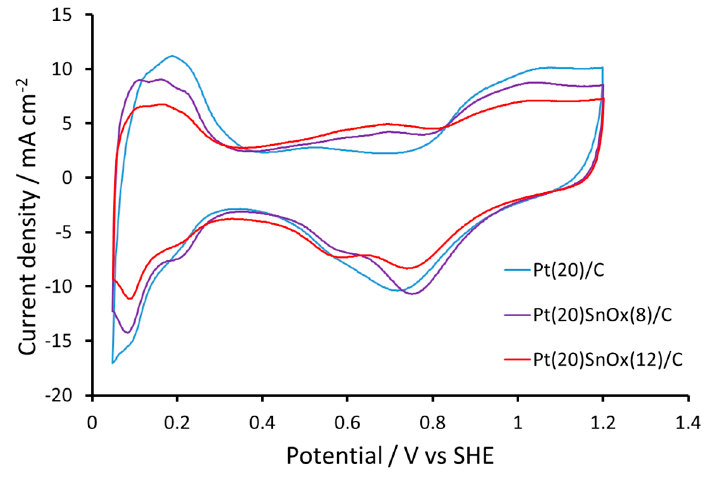
Figure 4. Cyclic voltammograms of electrodes with different catalysts in the supporting electrolyte obtained in an Ar saturated 0.5 M H 2 SO 4 solution at 20 mV/s. Currents are normalized to electrode geometric surface area.